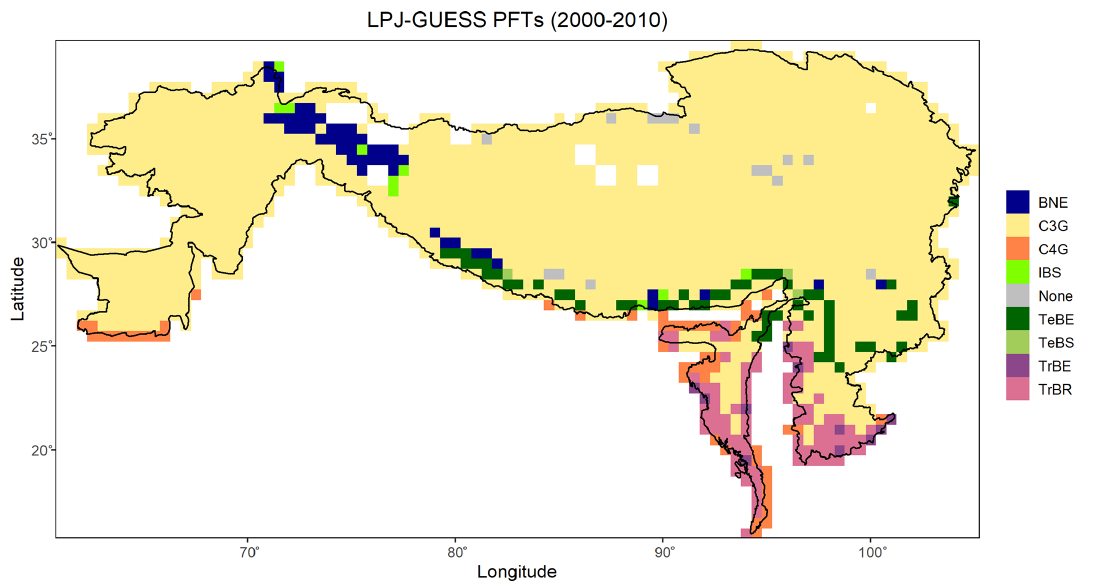
Figure 6. Average distribution of PNV simulated from 2000–2010 by LPJ-GUESS forced by CCSM4 climate. Full PFT names (as shown in legend) are as follows: BNE indicates boreal needle-leaved evergreen tree; C3G indicates C3 grass; C4G indicates C4 grass; IBS indicates shade-intolerant broadleaved; TeBE indicates temperate broadleaved evergreen tree; TeBS indicates temperate broad-leaved summergreen tree; TrBE indicates tropical broad-leaved evergreen tree; TrBR indicates tropical broadleaved raingreen tree.